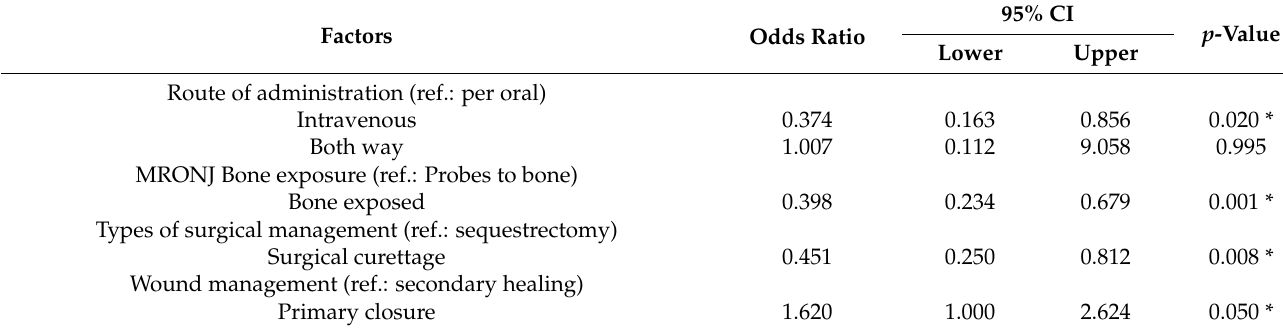
Table 3. Univariate ordinal logistic regression